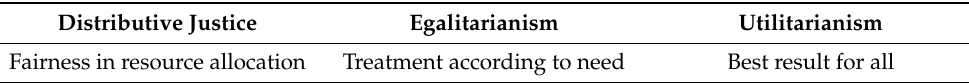
Table 1. Comparison of distributive justice, egalitarianism, and